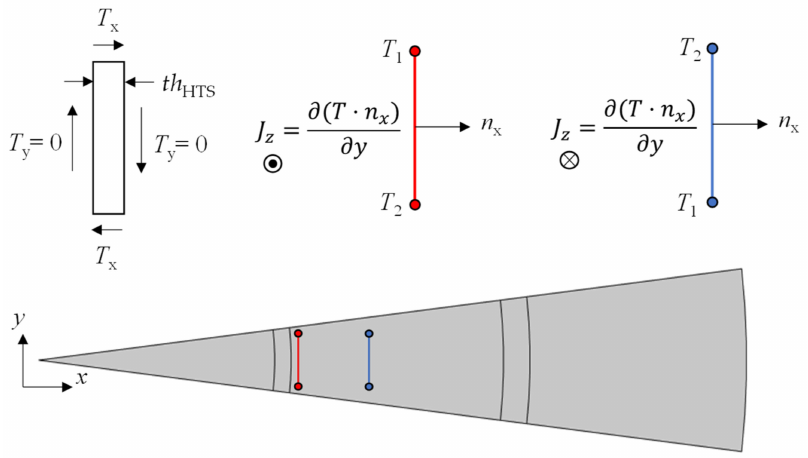
Figure 8. Boundary conditions for the T -formulation in the